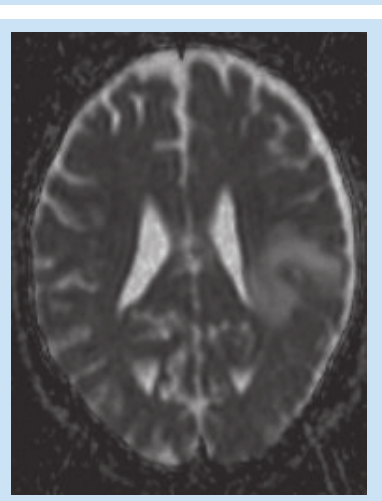
Fig. 2c. On the corresponding ADC map there is no restricted diffusion (white) confirming the T2 shine-through